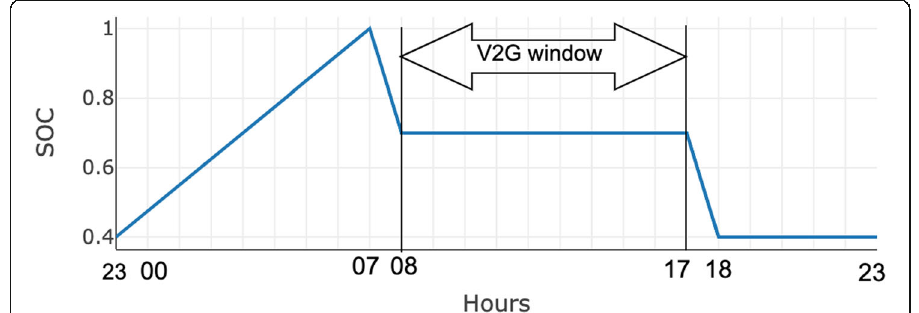
Fig. 2 SOC profile of an EV with no V2G